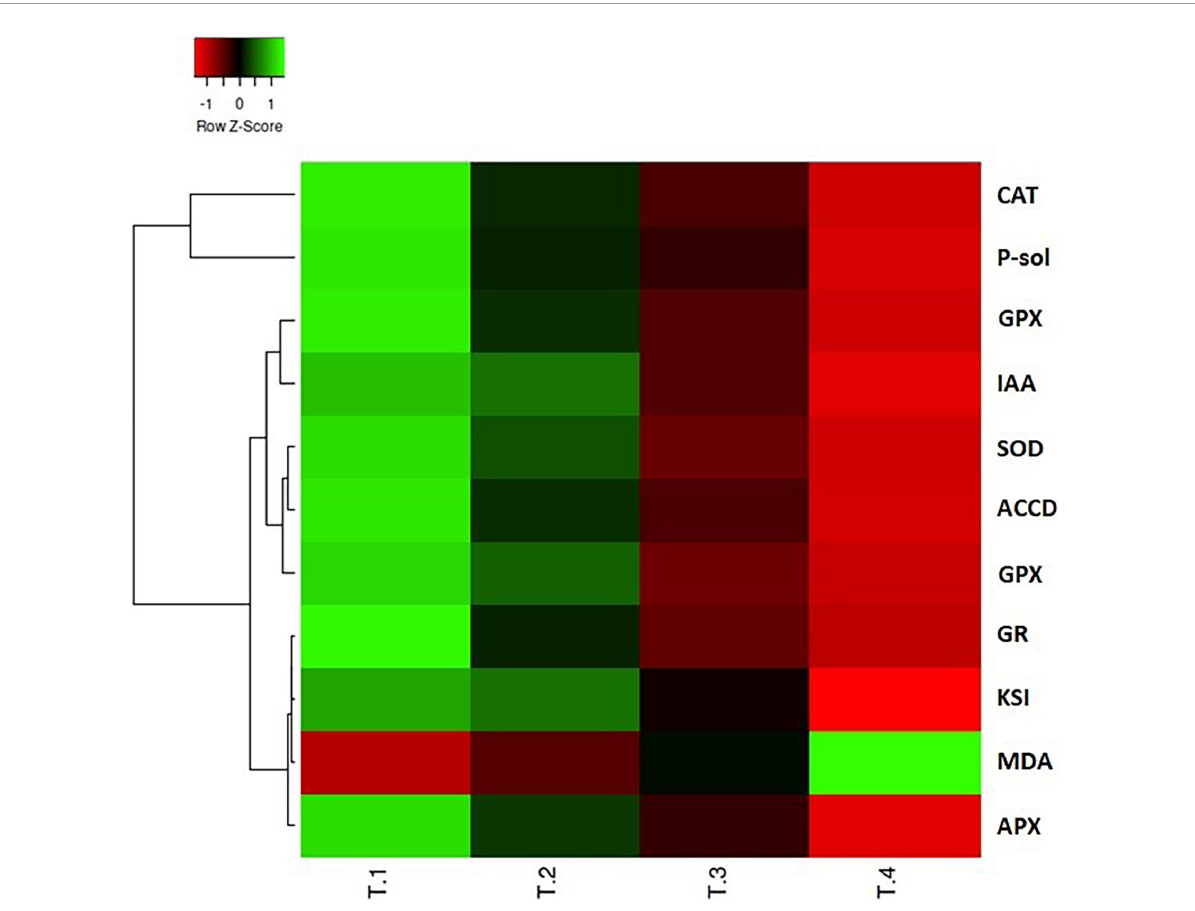
FIGURE6 Heatmap multivariate data analysis representing the responses of various variables of PGP attributes and antioxidant enzyme defense system against the different treatments of CBZM applied. T-1: control un-treated cell; T-2: recommended 1,000 µ g/ml CBZM; T-3: double dose, i.e., 2,000 µ g/ml CBZM; and T-4: triple dose, i.e., 3,000 µ g/ml CBZM. IAA, indole acetic acid; P-sol, phosphate solubilization; ACCD, ACC deaminase; Sid, siderophore; KSI, phosphate solubilization index; CAT, catalase; SOD, superoxide dismutase; GPX, glutathione peroxidase; APX, ascorbate peroxidase, polyphenol oxidase; GR, glutathione reductase; MDA,